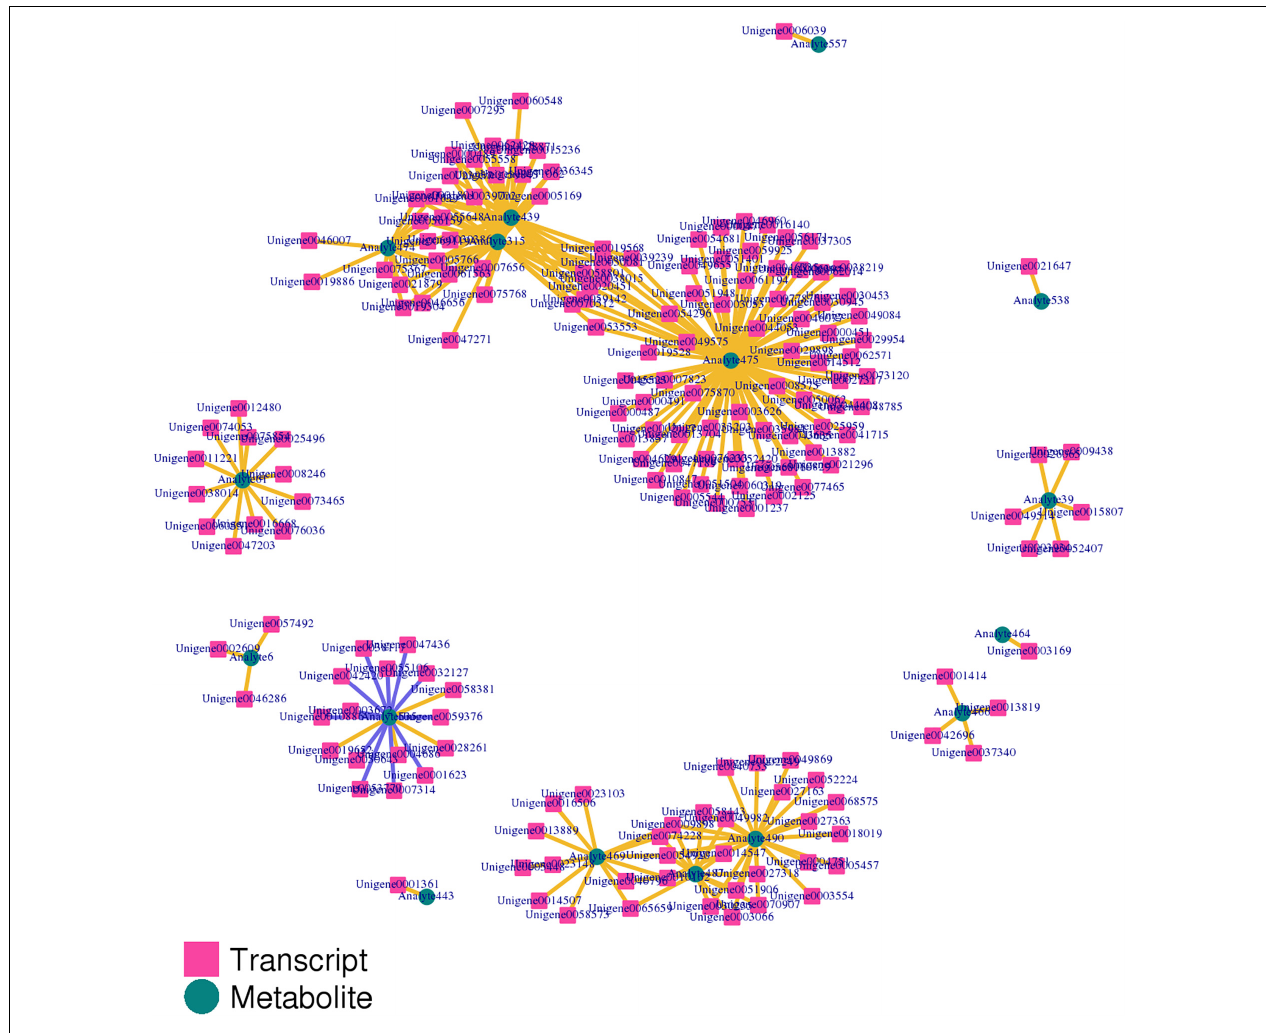
FIGURE 13 | The correlation network diagram of gene expression and metabolite